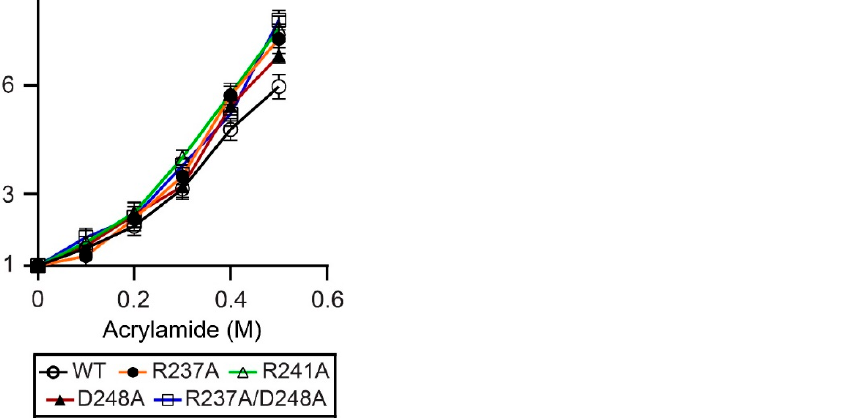
Figure 4. Acrylamide-induced quenching of PML enzyme fluorescence. F 0 —the fluorescence intensity in the absence of acrylamide; F—fluorescence intensity in the presence of acrylamide. Data presented correspond to the mean of three experiments.